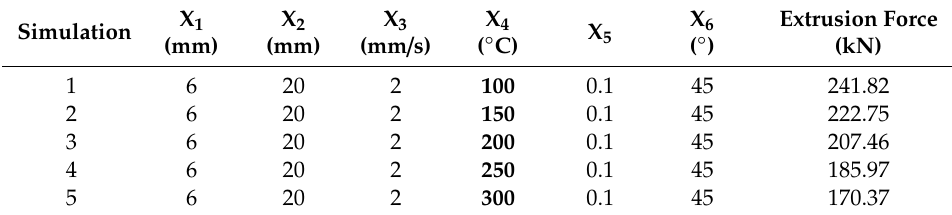
Table 9. Variables combination by varying X 4 (temperature).